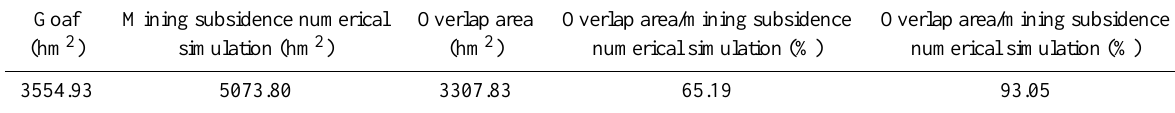
Table 1. The statistics of overlay